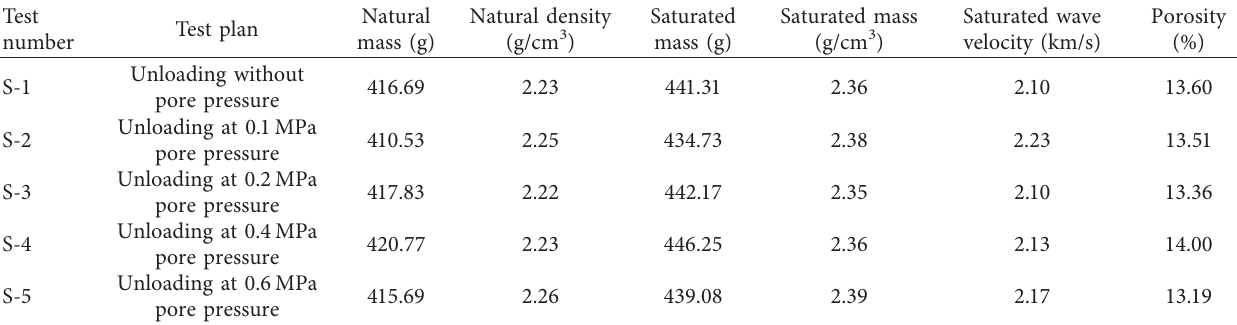
Table 1: Basic physical parameters of